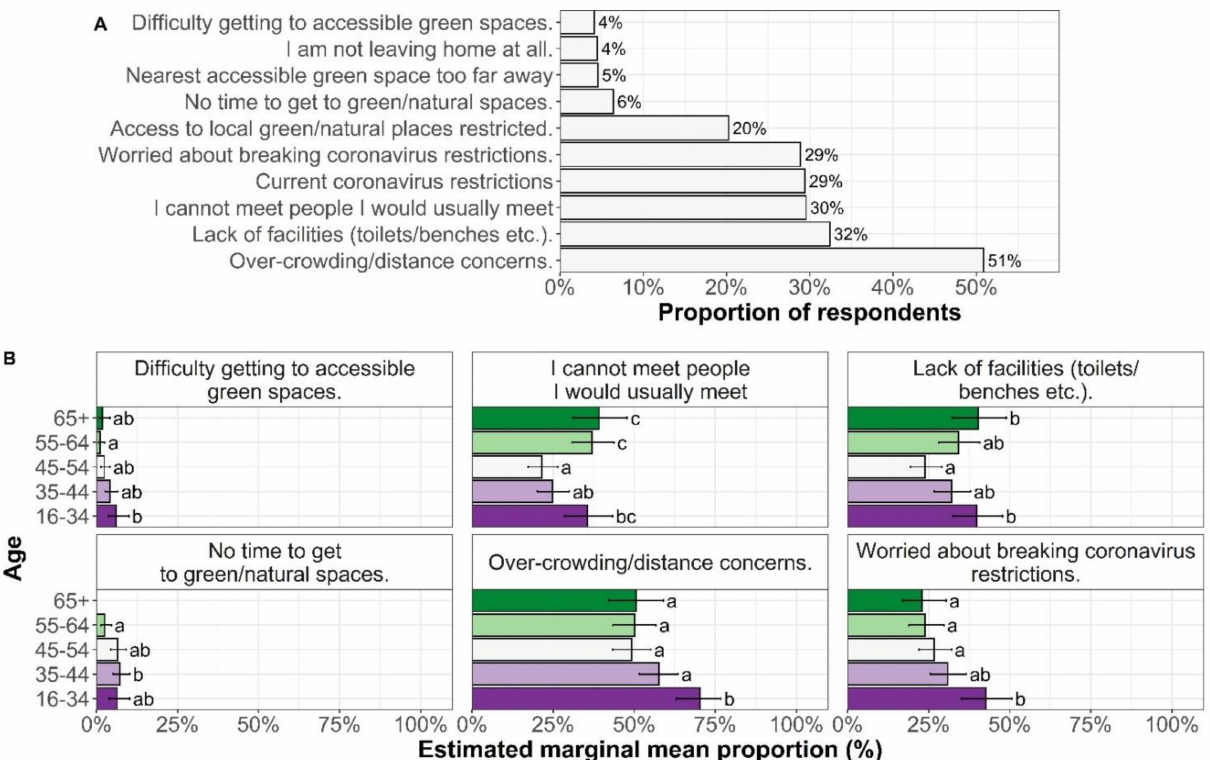
Figure 2. ( A ) Barriers to engaging with nature following the Covid-19 restrictions ( n = 2115); ( B ) Estimated marginal means for barriers by age group. Error bars = 95% confidence intervals; lettering indicates significant differences, within a panel, where categories do not share a letter, they are significantly different at a p < 0.05 level (with Tukey’s HSD adjustments for multiple comparisons). Only barriers with significant differences by age group are